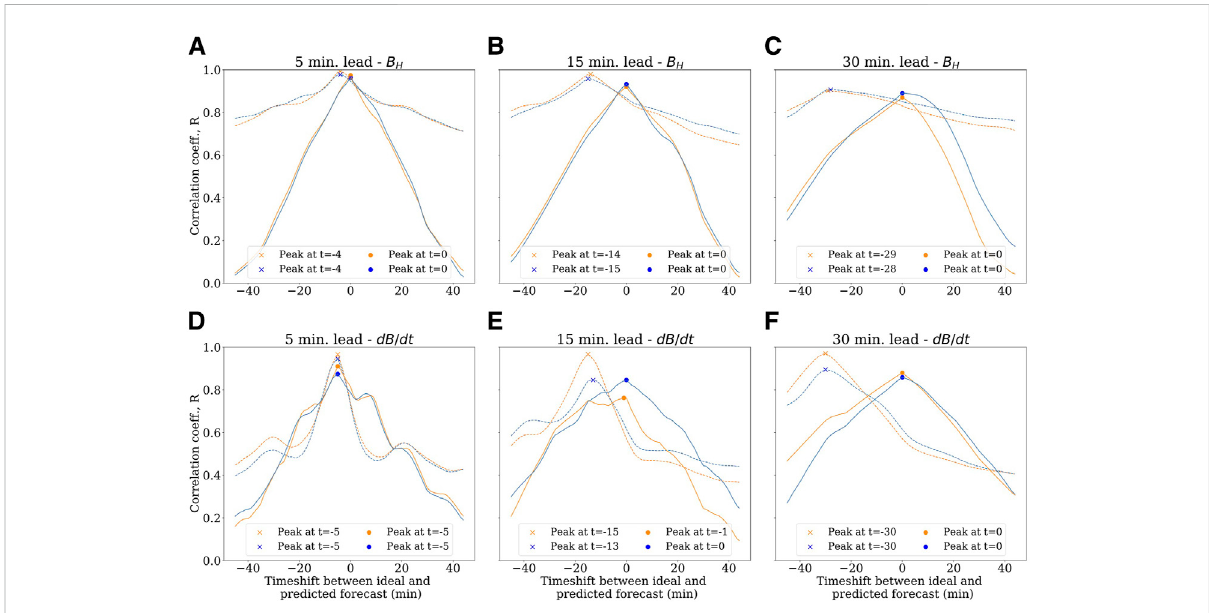
FIGURE 7 Temporal correlation between ideal and model-generated forecast of |B_H| (A – C) and |dB_H/dt| (D – F) at LER. × and correlation.Asbefore,orangerepresentsLSTMandbluehybridmodels;solidlinesarefordirectlydrivenpartsofthestormanddottedlinesrepresent full